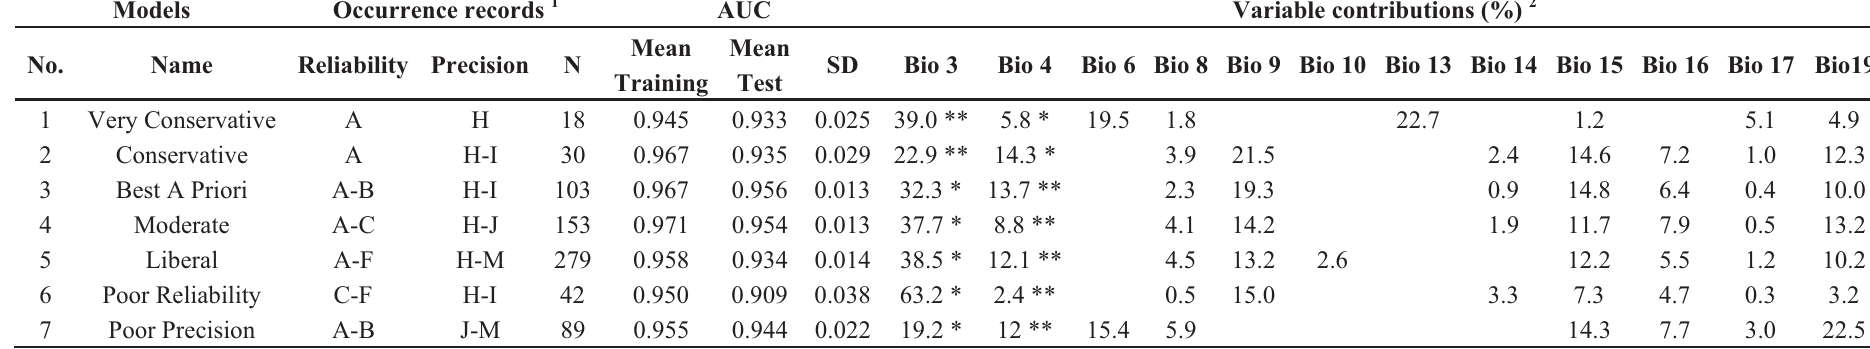
Table 3. Occurrence records, area-under-the-curve (AUC) statistics, and variable contributions to bioclimatic ecological niche models for the white-nosed coati ( Nasua narica ) in Arizona and New Mexico.